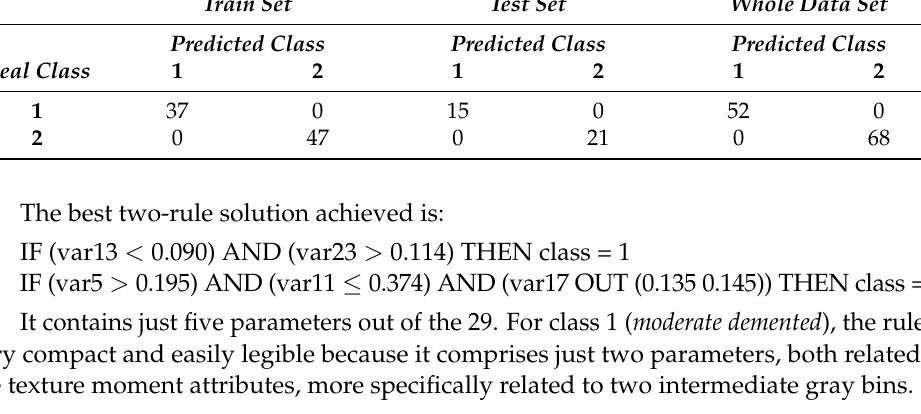
Table 3. Confusion Matrices of the Best Rule Set (2-Class Problem). Train Set Test Set Whole Data Set Predicted